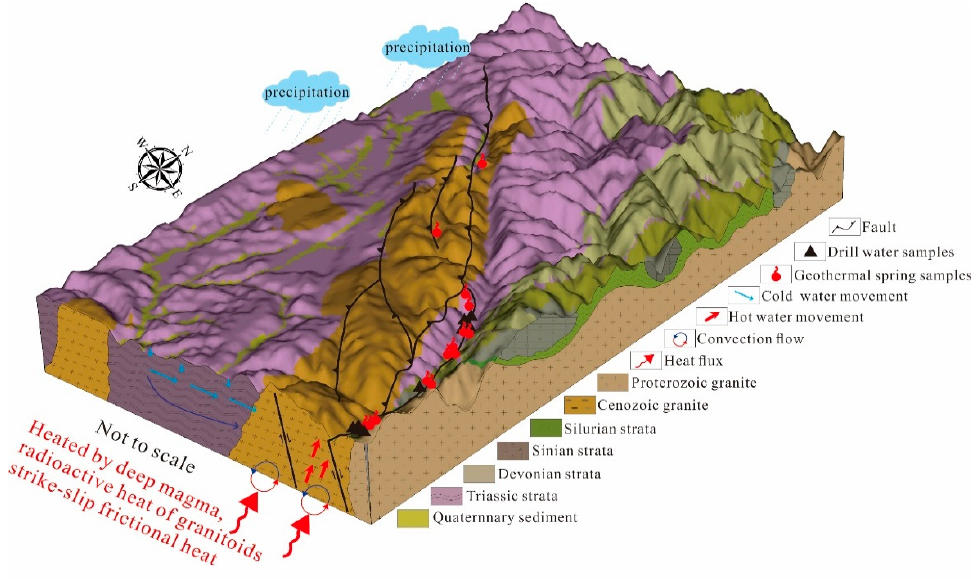
Figure 12. Preliminary conceptual model of the geothermal system in the XFZ.